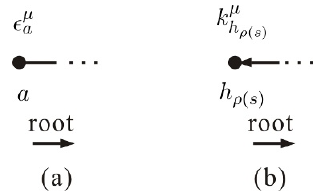
Figure 1 . Two types of internal nodes of chains.